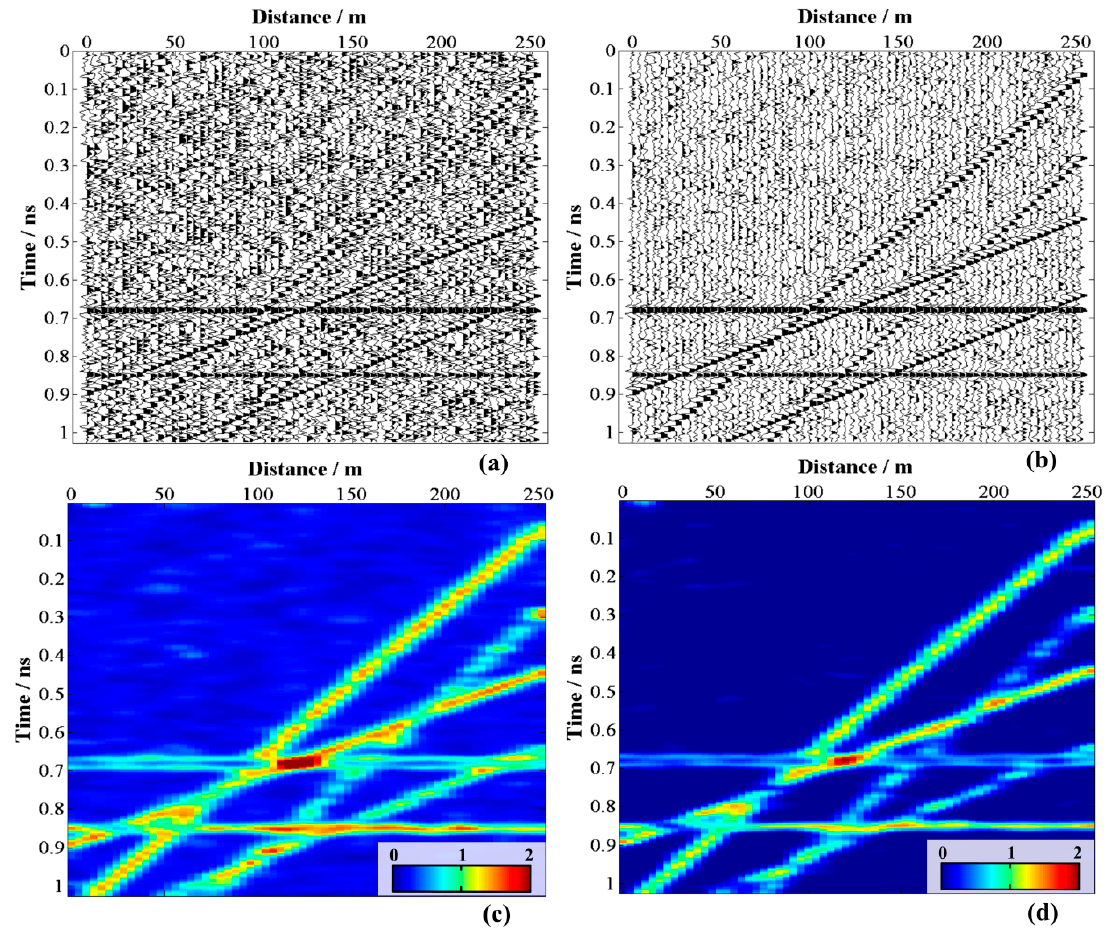
μσ ( , )= (0,0.0003) N N Figure 5. ( a ) Noisy data with N ( µ , σ ) = N ( 0,0.001 ) , ( b ) Noisy data with N ( µ , σ ) = N ( 0,0.0003 ) , ( , )= (0,0.001) N N μσ Figure 5. ( a ) Noisy data with , ( b ) Noisy data with , ( c ) ( c ) Local similarity between ( a ) and ( b ), ( d ) Local similarity spectrum after soft Local similarity between (a) and (b), ( d ) Local similarity spectrum after soft thresholding.